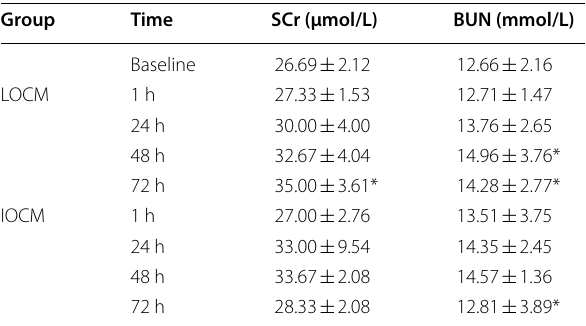
*Represents p < 0.05 versus baseline